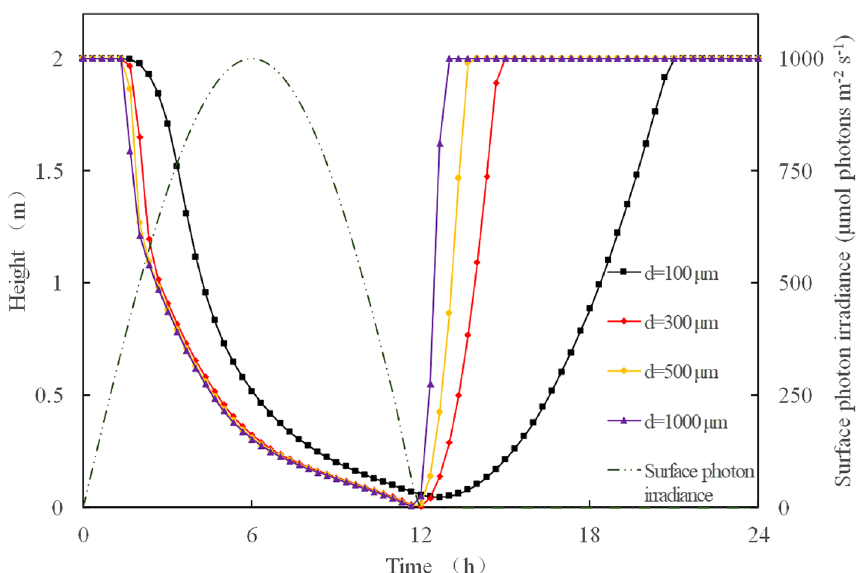
Figure 5. Vertical migration of Microcystis colonies under varying light